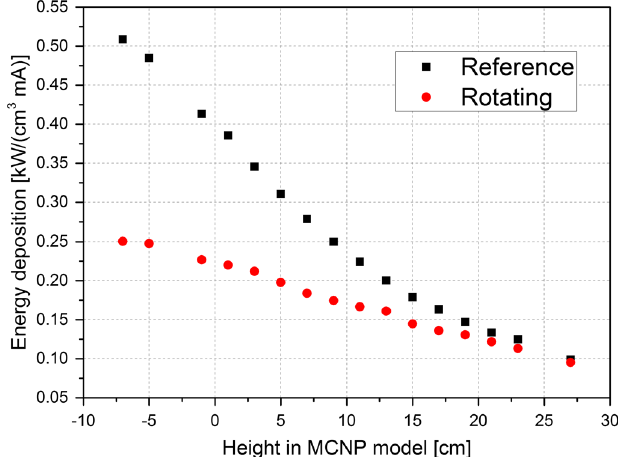
FIG. 10. Power density in the middle of the central rods (only in the lead) along the target height. The relative error of the values is below 3%.